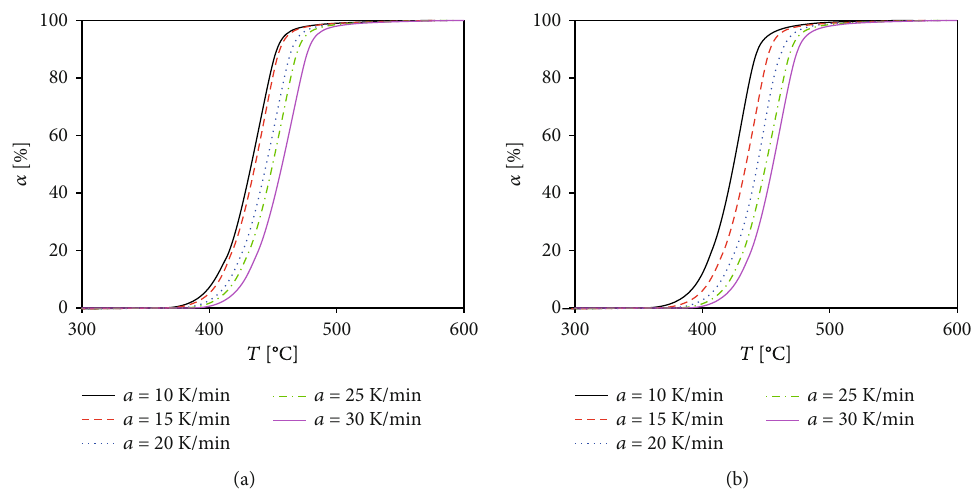
Figure 2: Devolatilization rate of the PET (a) and recycle PET (b) samples.